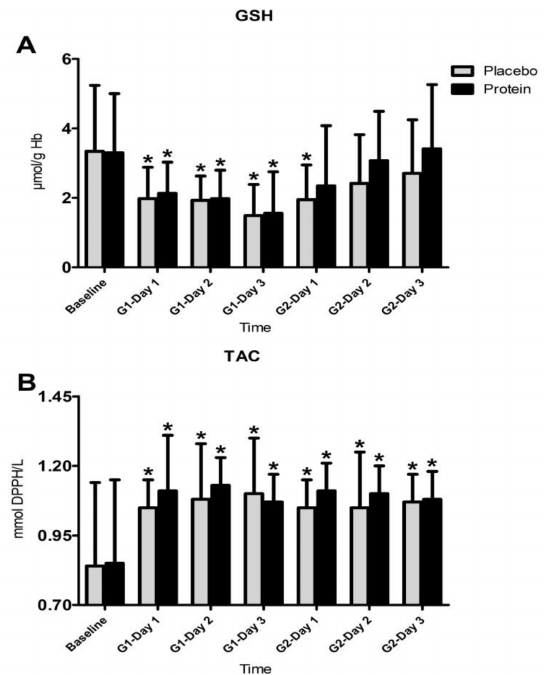
Figure 6. Changes in reduced glutathione ( A ) and total antioxidant activity ( B ). GSH, reduced glutathione; TAC, total antioxidant activity; G1, game 1; G2, game 2; * denotes a significant difference with baseline at p <